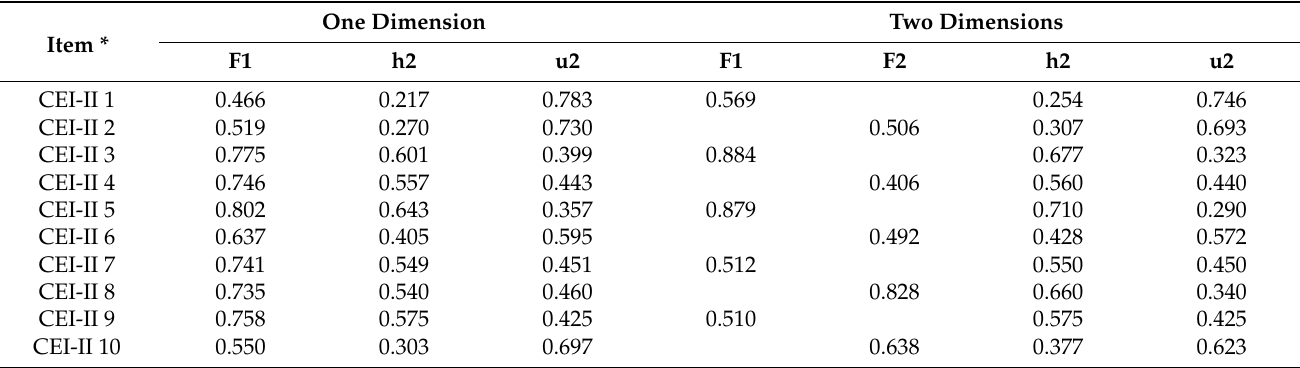
Table 2. Pattern matrix based on the polychoric matrix using unweighted least squares.